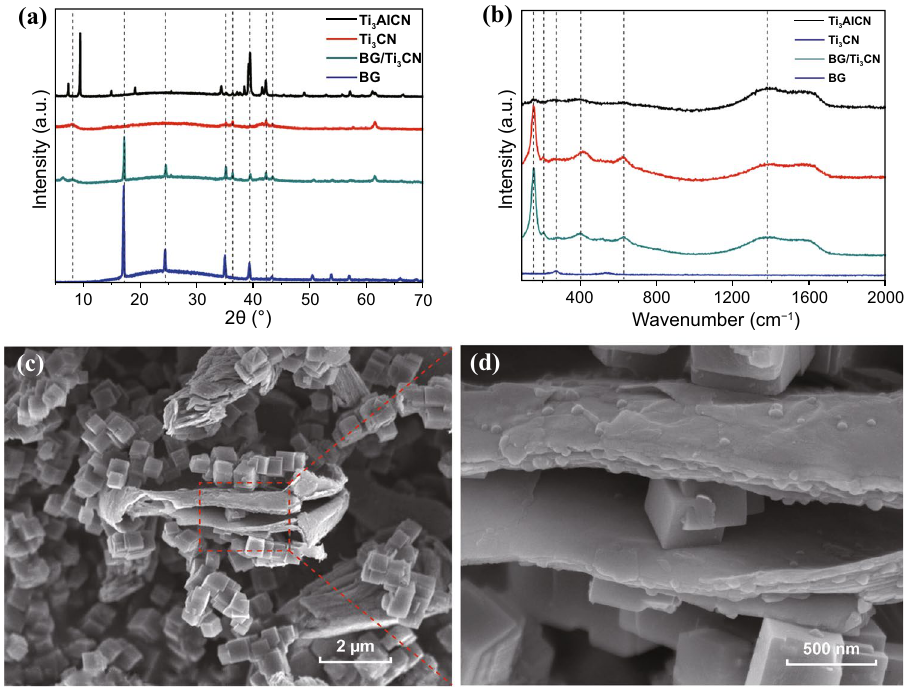
Fig. 5 a XRD patterns and b Raman spectra of Ti 3 AlCN, Ti 3 CN, BG, and BG/Ti 3 CN (1:1). c, d FESEM images in a different amplification of BG/Ti 3 CN BG/Ti 3 CN